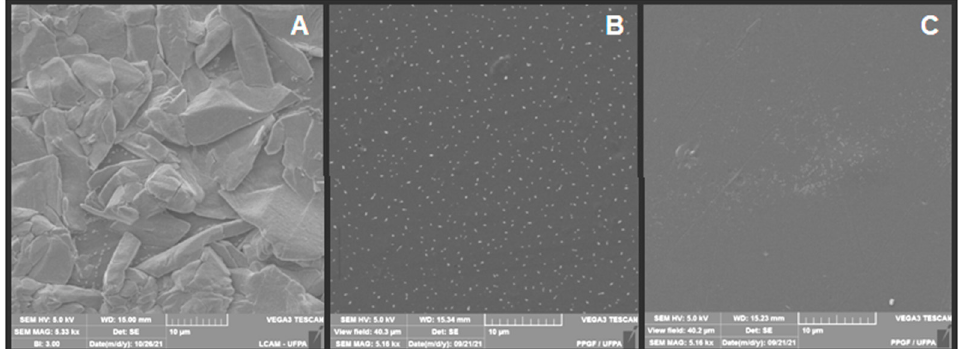
Figure 7. Micrographs obtained by SEM of membranes at the amplitude of 5 kv: ( a ) M0, ( b ) M1, ( c ) M2, ( d ) M3. The bar is 10 μ